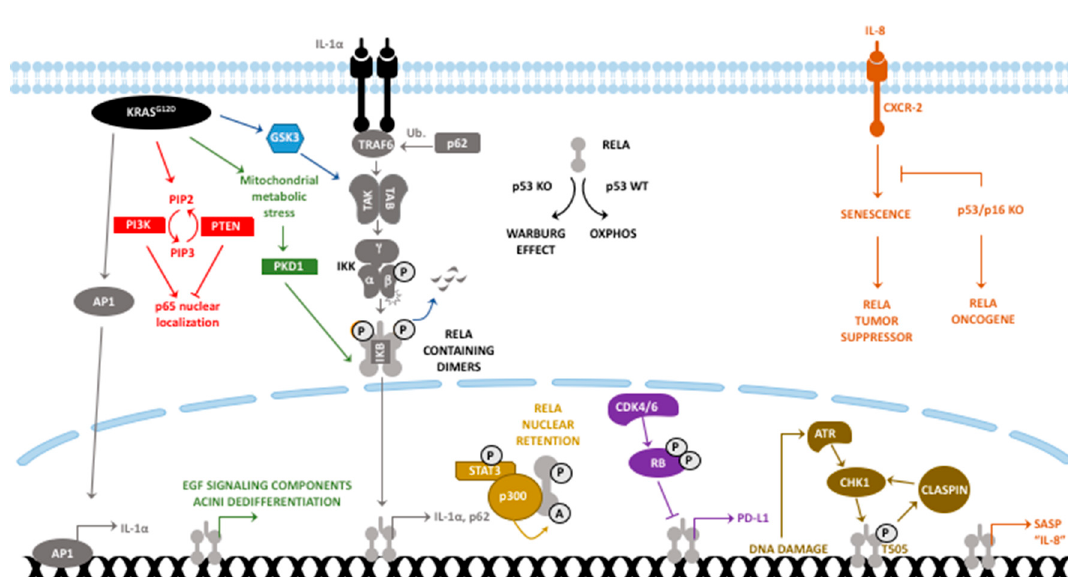
Figure 1. Reported and potential oncogenic and tumor suppressor functions of RelA in pancreatic carcinogenesis and tumor maintenance are depicted. Each color indicates an individual signaling axis although crosstalk is highly expected. P: Phosphorylation, A: Acetylation, Ub: Ubiquitination.